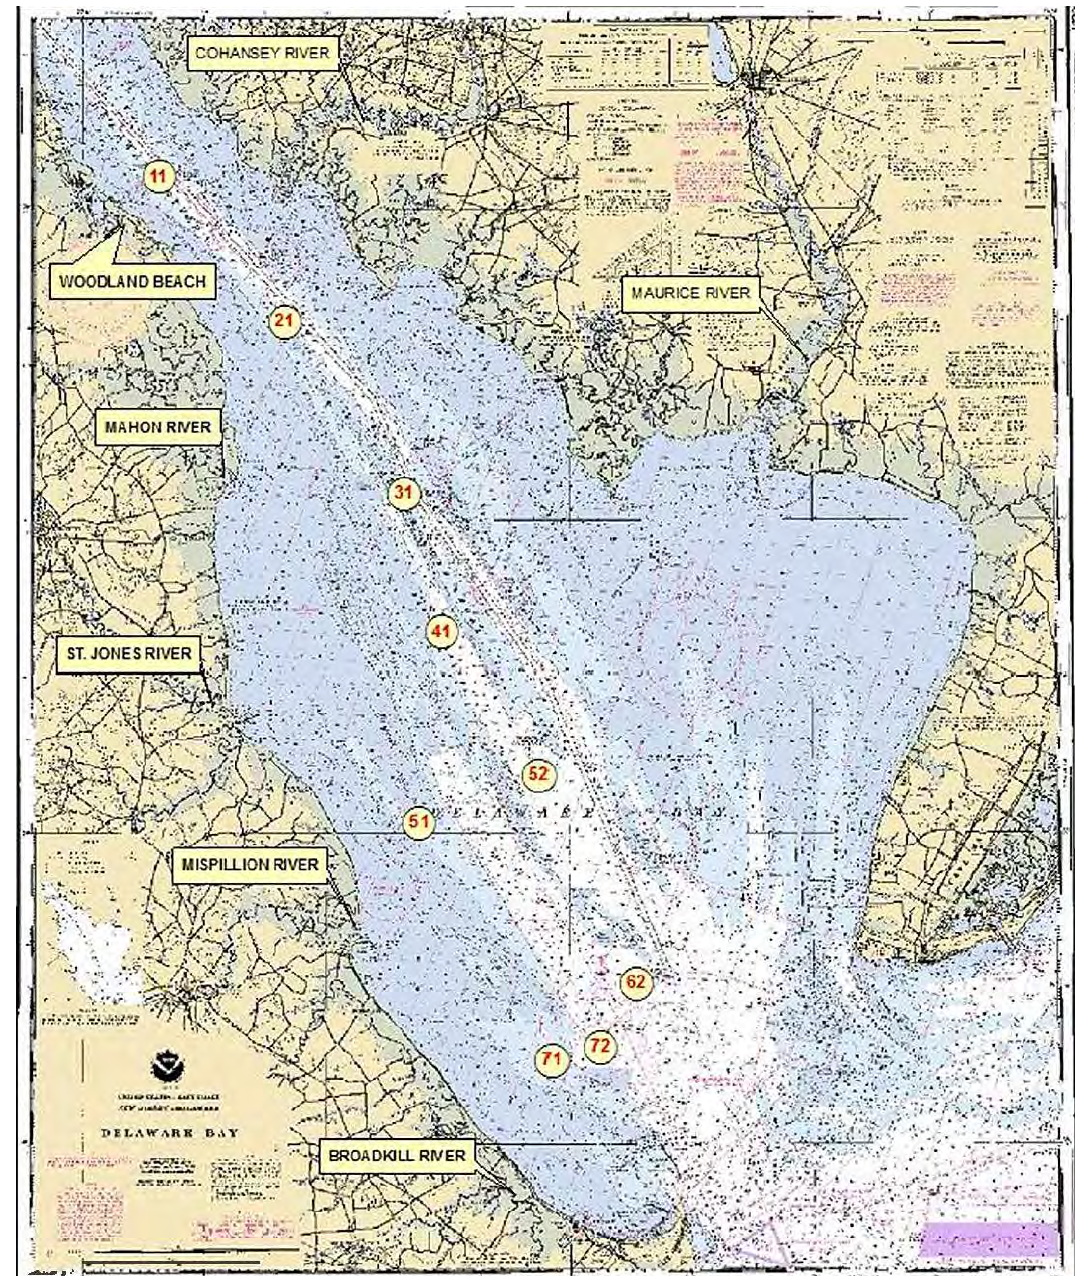
Figure 52. Delaware Fish & Wildlife Adult Trawl Survey sampling area and